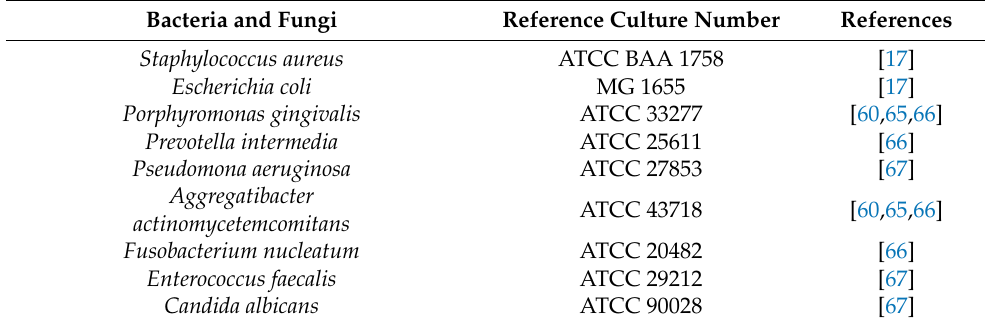
Table 3. Reference cultures of bacteria and fungi used in studies. Bacteria and